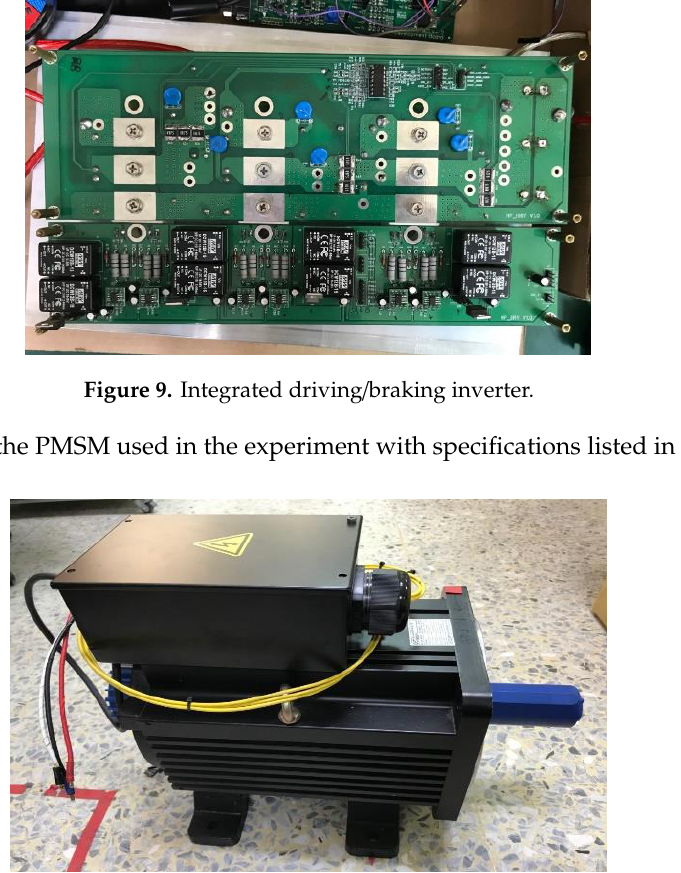
Figure 10. PMSM used in the experimental electric vehicle.